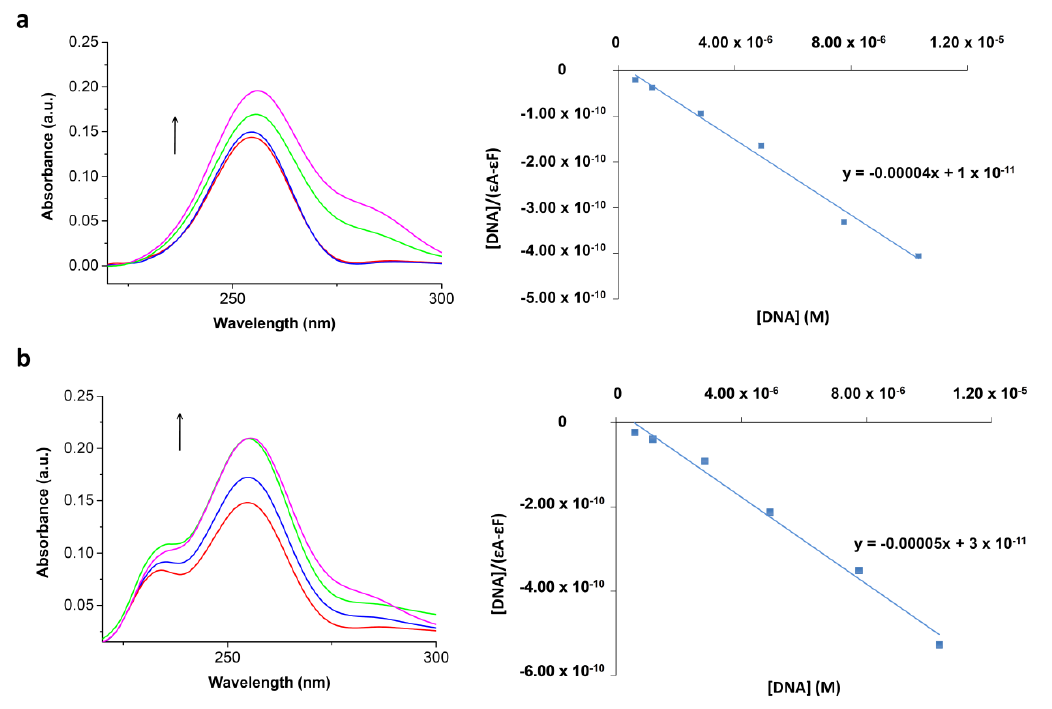
Figure 3. Absorption spectra of N -butylacridone 2 and N , N (cid:48) -dibutyl-9,9 (cid:48) -biacridylidene 9 in 15 mM